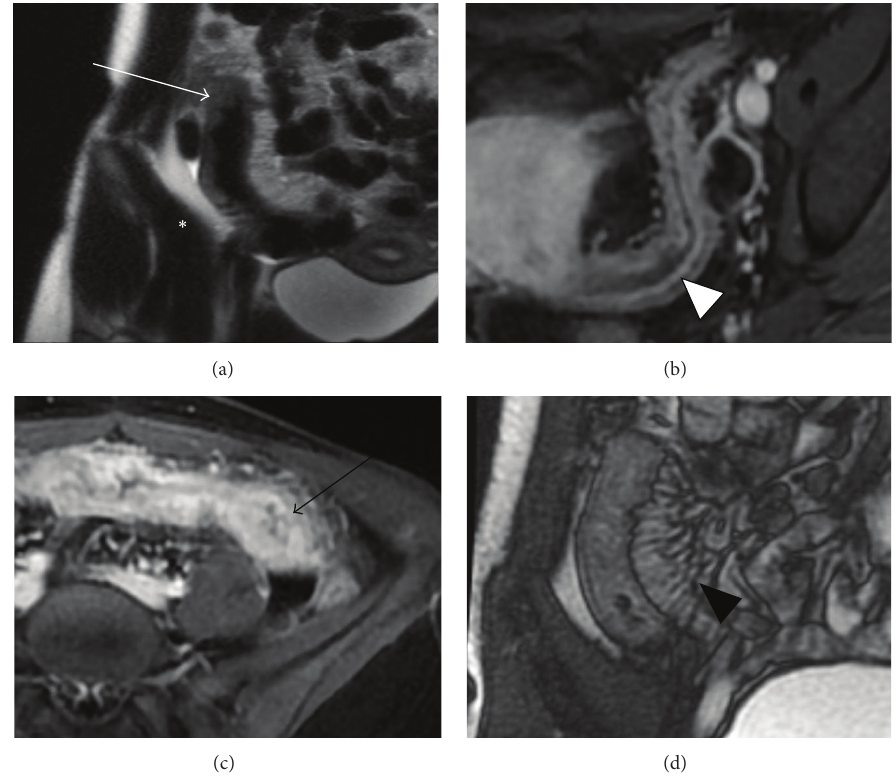
Figure 1: MR enterography features of active Crohn’s disease. (a) Coronal T2-weighted image demonstrates wall thickening (arrow), axial T1-weighted fat-suppressed postcontrast images obtained in enteric (b) and delayed (c) phases demonstrate early mucosal ((b), arrowhead) with progressive transmural ((c), arrow) enhancement; coronal balanced steady-state free precession image (d) demonstrates mesenteric hypervascularity